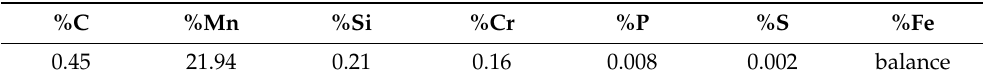
Figure 1. Thermodynamic equilibrium for precipitation of (Mn,Fe) 3 C (ThermoCalc). Table 1. Chemical composition of the TWIP steel (weight